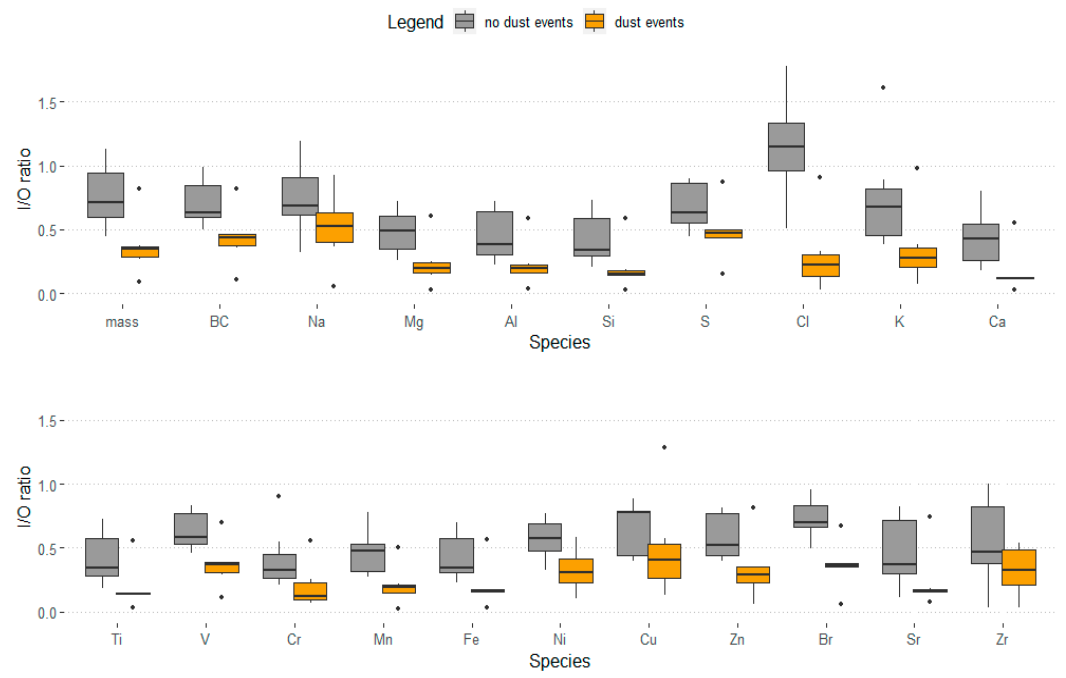
Figure 2. Box plots illustrate the difference between I/O concentration ratios of PM 2.5 mass, BC, and 19 elements during dust and non-dust events.